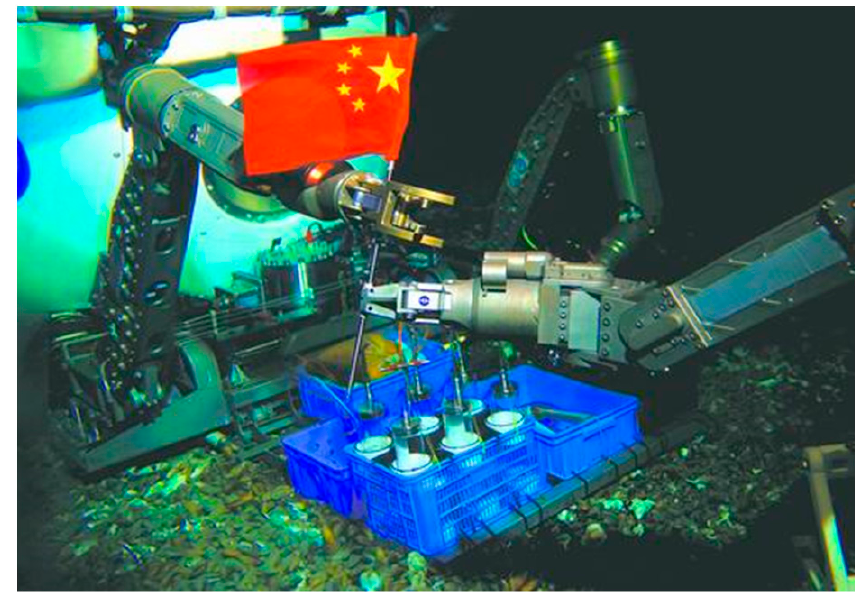
Figure 2. Haima ROV and Shenhai Yongshi HOV handover national flags.